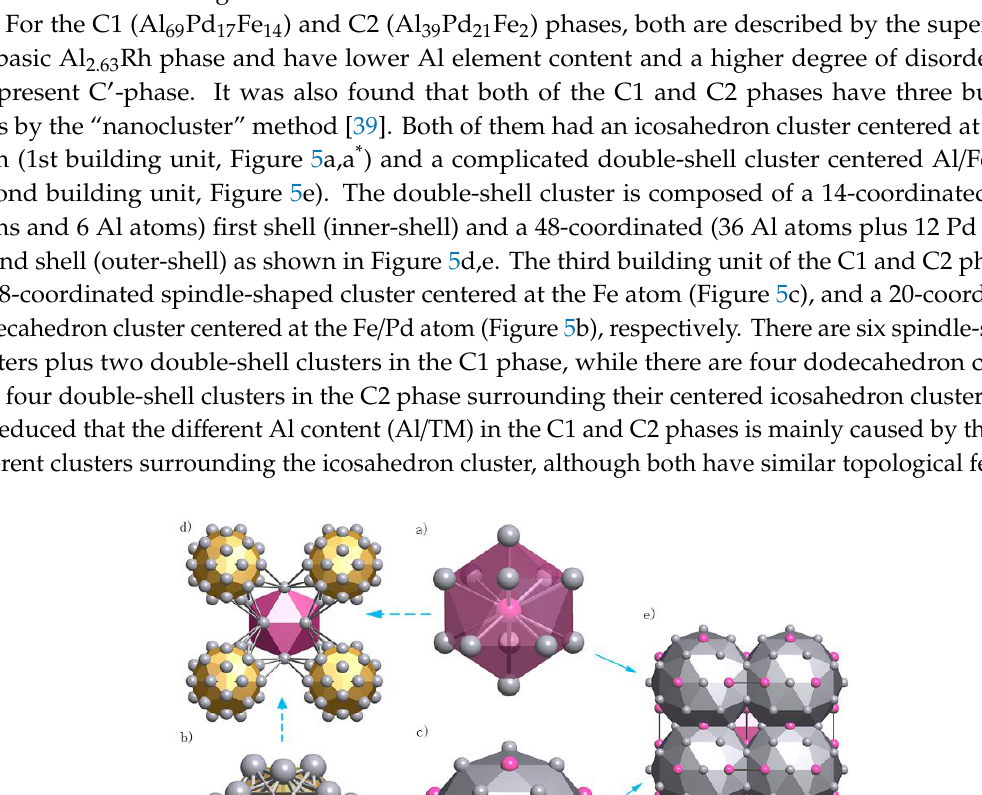
Figure 5. Building units and their packing around high symmetric positions in the C1 and C2 phases. ( a ) and ( a* ): the first building unit which is an icosahedra cluster; ( b ) the third building unit of the C2 phase; ( c ) the third building unit of the C1 phase; ( d ) the inner-shell of the second building unit; ( e ) the outer-shell of the second building unit; ( f ) packing pattern of the C2 phase; ( g ) packing pattern of the C1 phase. One can easily conclude that all three of the aforementioned phases can be simply described as an icosahedron cluster centered at a Pd atom plus eight identical (C′) or different ( C1 and C2) polyhedron clusters. In other words, the C′, C1 , and C2 phases are mainly distinguished from their second and third building units. The C1 and C2 phases have a different second building unit and additional third building unit from those of the C′ phase. There are 2(4) second building and 6(4) third building units to total eight clusters surrounding the first building unit for the C1 (C2) phase. It is the different type and number of second and third building units, as well as the site of occupancy, that decides the different content of Al elements in these three phases. 4. Conclusions